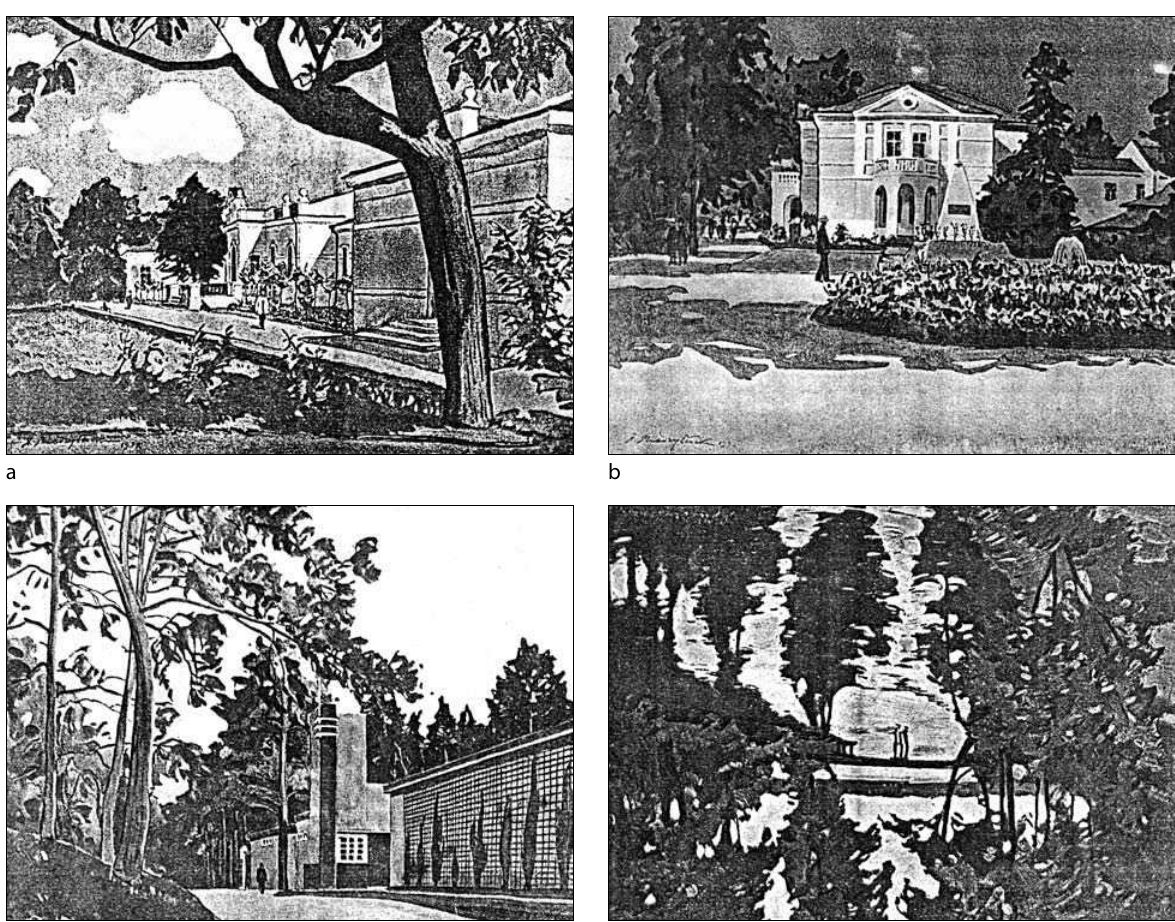
Fig. 5. Drawings of the Polish artist adam Miedzyblocki (1890–1956): a, b – old sanatorium and park in Druskininkai; c – park of cure physical culture; d – the ratnyčia river meets